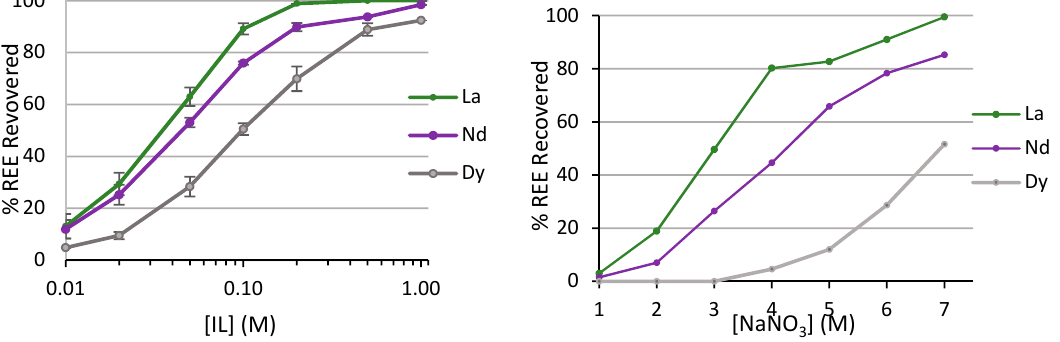
Figure 1. ( Left ): the recovery of La, Nd, and Dy (0.01 M) from an NaNO 3 (7 M) aqueous solution varying IL concentration (0.01–1.0 M) in toluene (recorded in triplicate). ( Right ): The recovery of La, Nd, and Dy (0.01 M) using IL (0.10 M) in toluene varying NaNO 3 concentration (1–7 M). Interpolation used to aid the eye only.